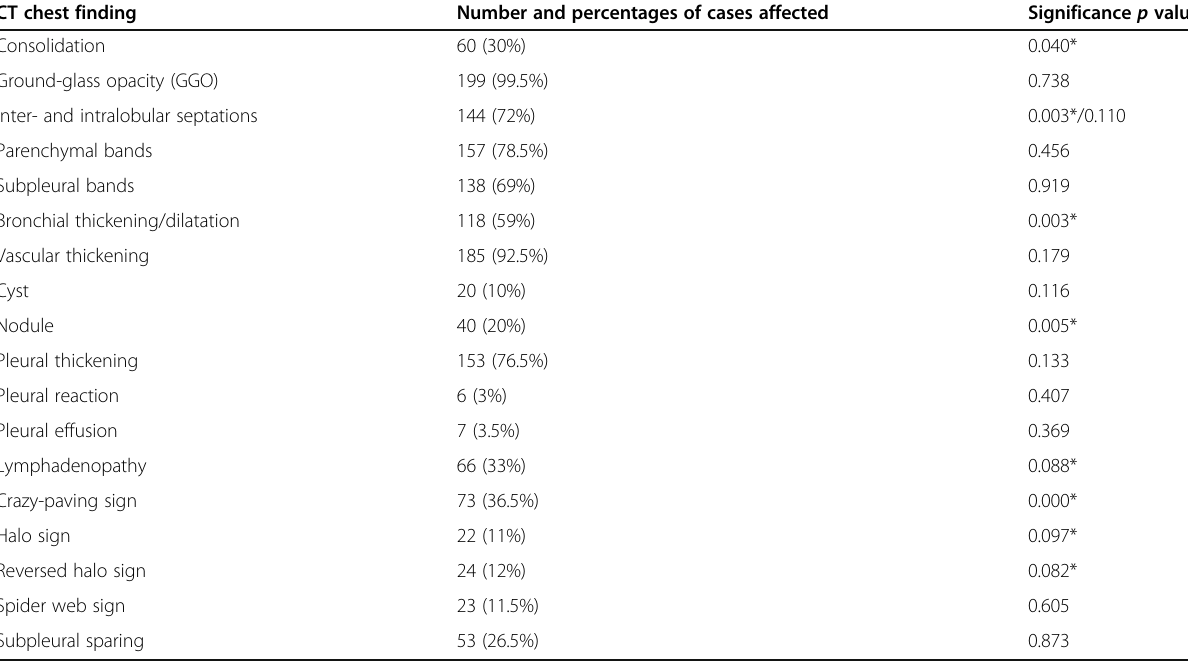
Table 3 CT chest findings in cases with COVID-19 pneumonia, number, and percentages of cases with a severity significance value CT chest finding Number and percentages of cases affected Significance p